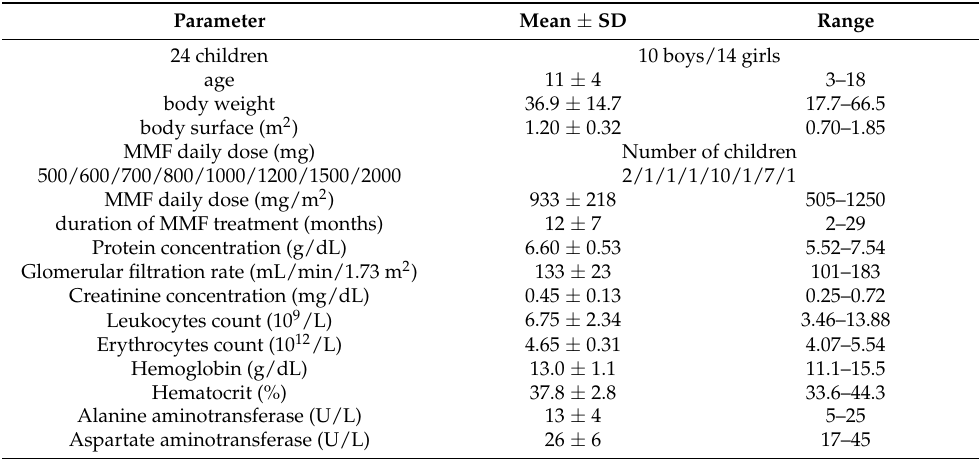
Table 5. Demographic and biochemical characteristics of the study